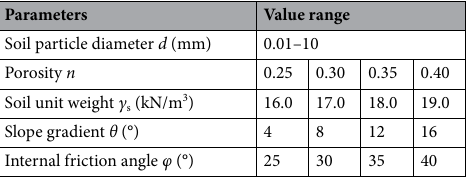
Table 6. Comparison of critical shear stress results calculated by Eqs. (15), (23) and (24).